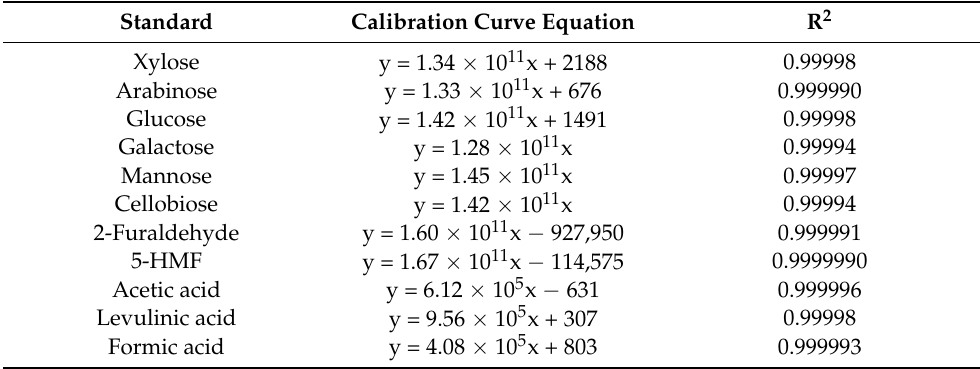
Table 2. Standard equations of the calibration curves.